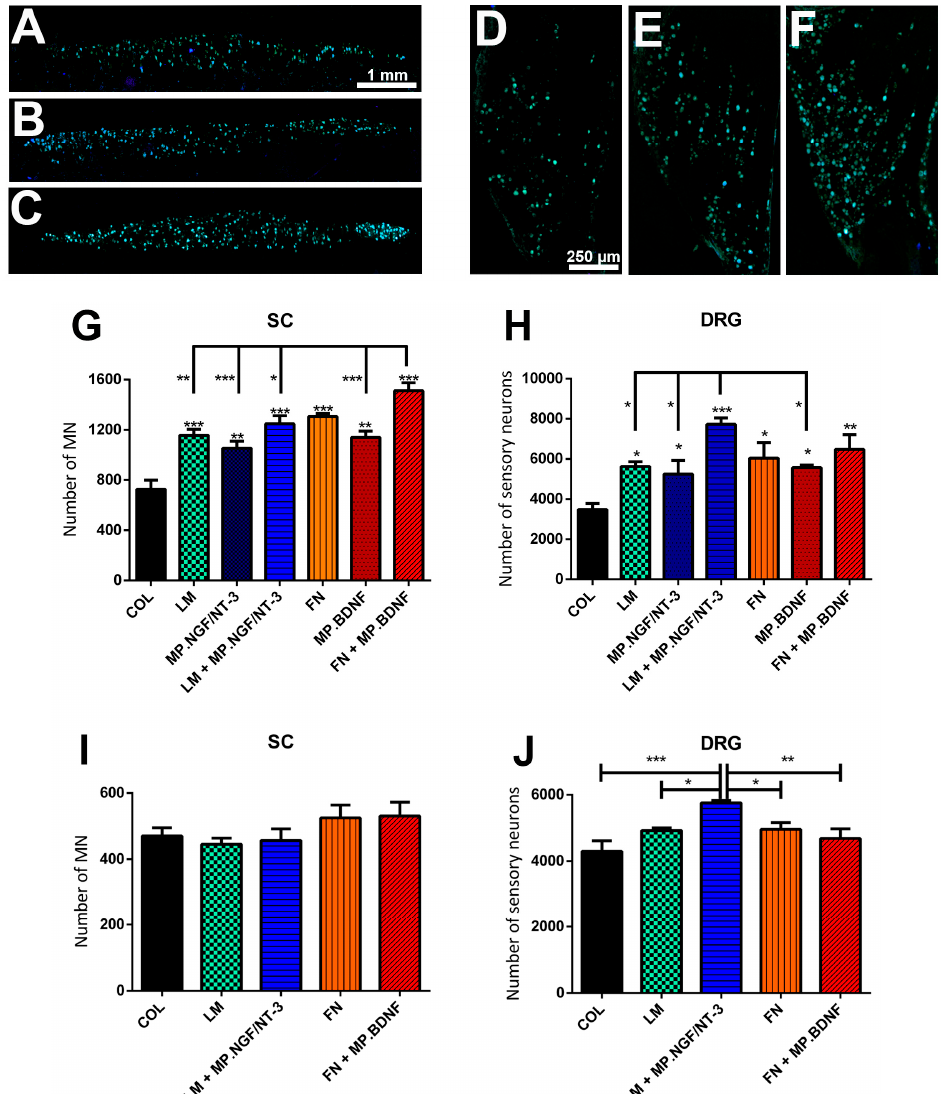
Figure 3. ( A – F ) Representative micrographs of neurons retrolabeled with FG in the spinal cord ( A – C ); and DRG ( D – F ) of rats after sciatic nerve section and repair with a nerve conduit filled: with COL ( A , D ); LM + MP.NGF/NT3 ( B , E ); or FN + MP.BDNF ( C , F ). ( G – H ) Histogram of the number of regenerated motor neurons in the spinal cord ( G ) and sensory neurons in the DRG ( H ) in the short term (20 days after injury) study. ( I , J ) Histogram of the number of regenerated motor neurons in the spinal cord ( I ) and sensory neurons in the DRG ( J ) after application of FG retrotracer at the ankle level 75 days after injury. Data expressed as mean ± SEM. * p < 0.05, ** p < 0.01 and *** p < 0.001.